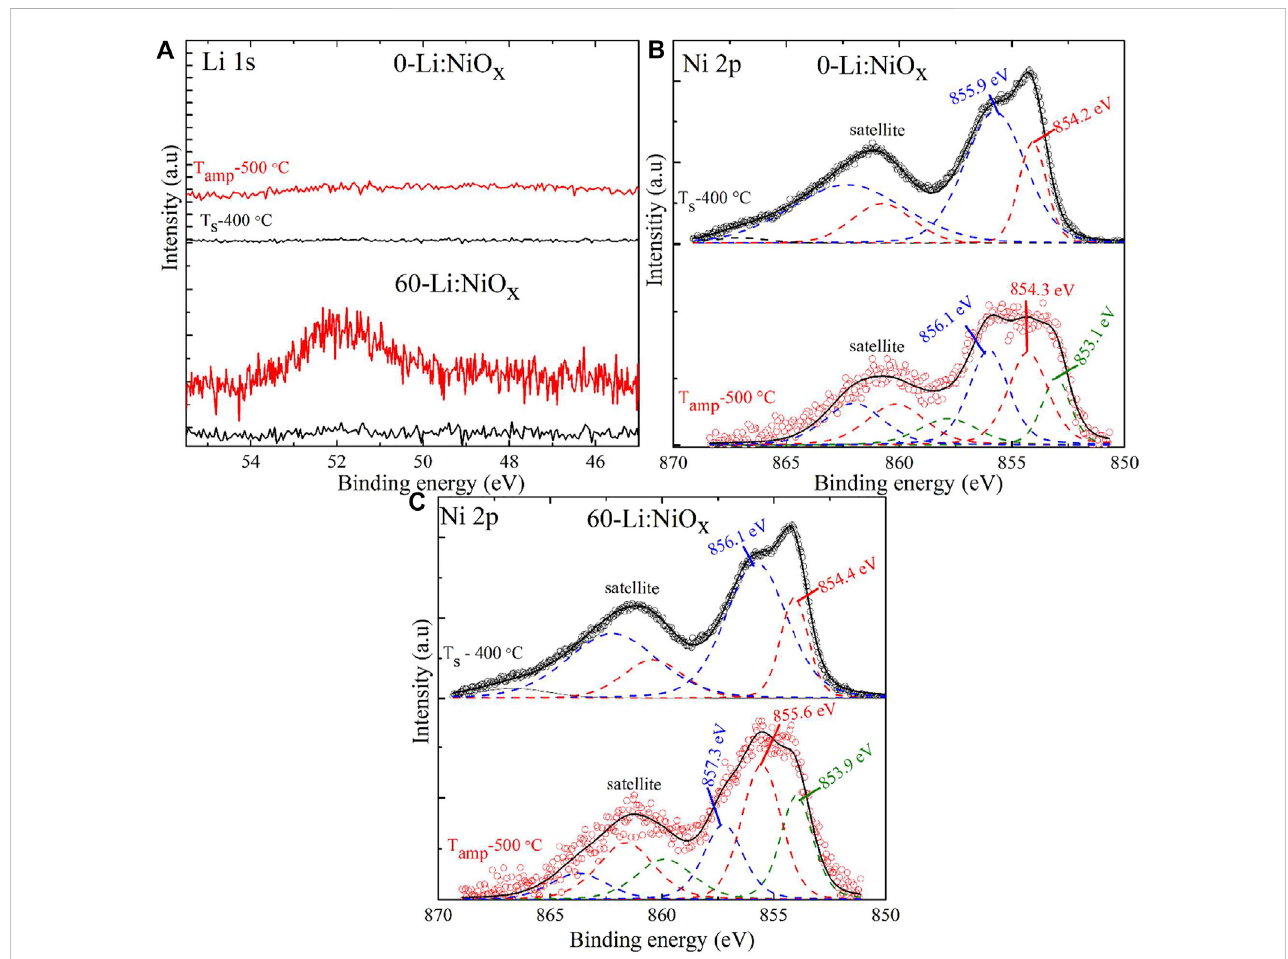
FIGURE 6 X-ray photoelectron core-level spectra for both as-deposited (Ts = 400 ° C) and ampoule-annealed (T amp = 500 ° C) fi lms: (A) Li 1s region for (0, 60)-Li: NiO x , (B) Ni 2p region for the 0-Li:NiO x , and (C) Ni 2p region for the 60-Li:NiO x thin fi